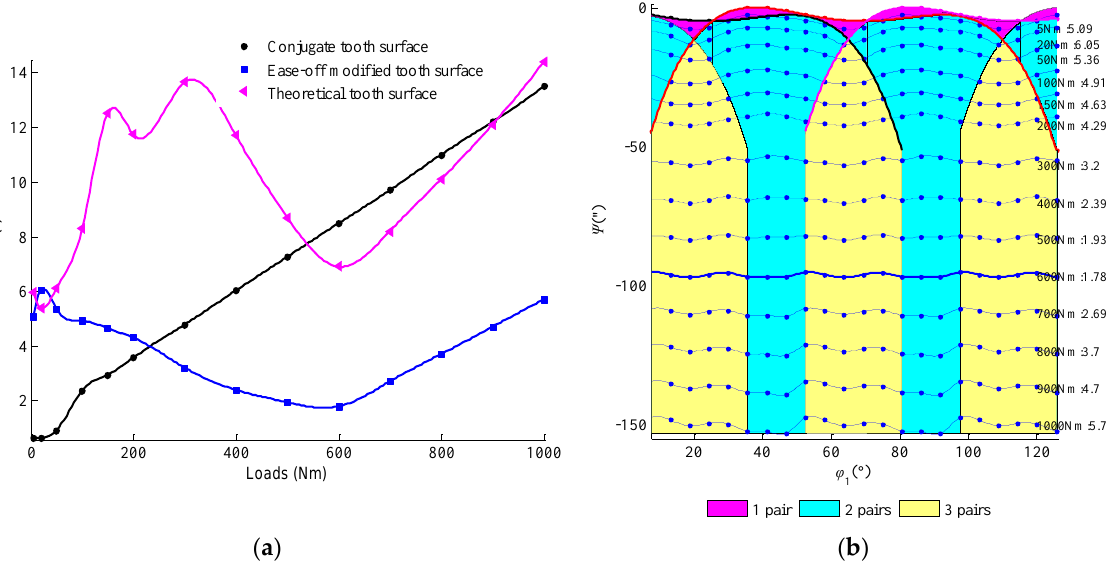
Figure 7. Loaded transmission error and its amplitude under loads. ( a ) Amplitude of loaded transmission error under loads. ( b ) Loaded transmission error under loads for the best ease-off tooth.